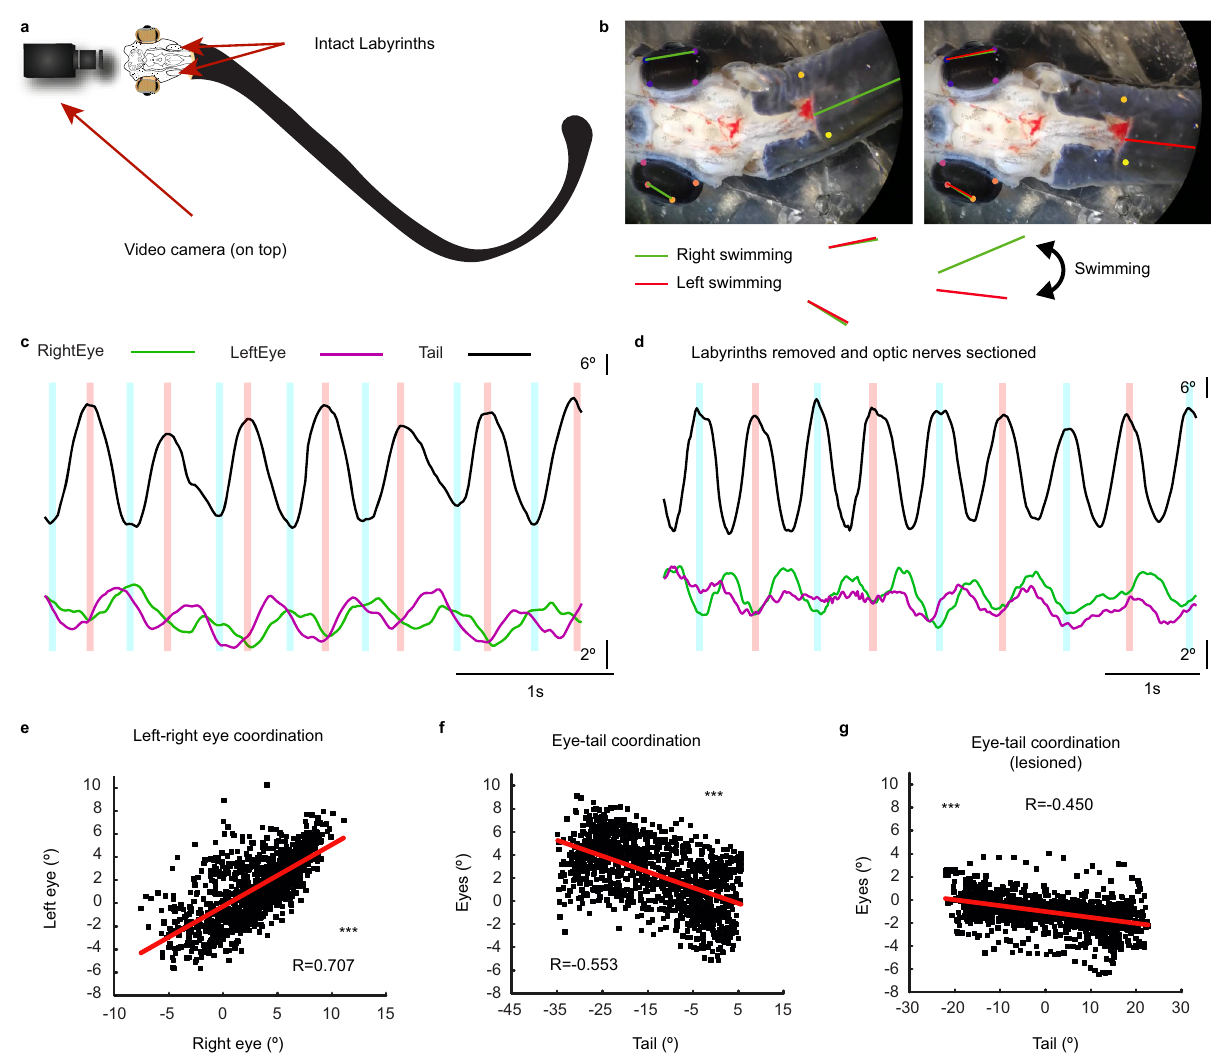
Fig.9|Locomotionevokedeyemovements.a Schematicshowingthesemi-intact lamprey preparation used to monitor body and eye movements. The rostral seg- ment up to the spinal cord is dissected according to the same principles as the ex vivo preparation, exposing the brain and the eyes. The remainder of the body and tail were kept intact in order to allow locomotion. A video camera was placed coupledtoamicroscopeto fi lm thepreparationfrom above. b Eitherspontaneous ortactilelyinducedlocomotion(bygentlypinching thetail)wasrecorded, and eye andbodymovementswereanalyzed overtime.Eyemovementssynchronized with swimming activity were observed. Images show two different positions of the eyes and the tail during a swimming episode. c Trajectories of the tail (black) and eyes